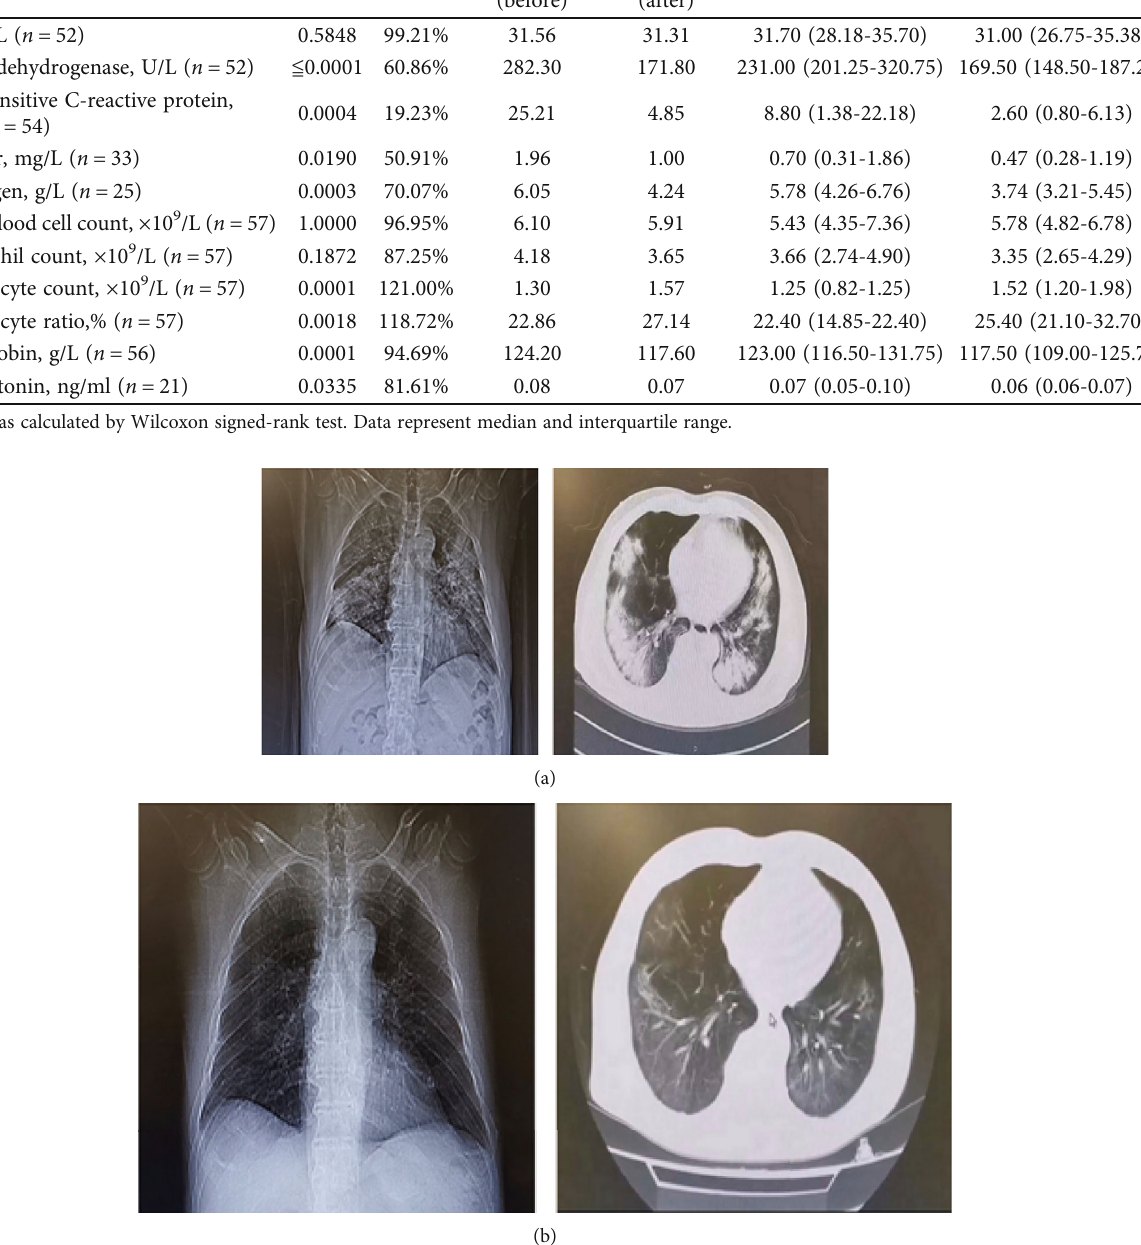
Figure 1: Laboratory indicators and chest imaging of COVID-19 patients before and after treatment. Representative chest imaging at (a) admission and at the (b) end of